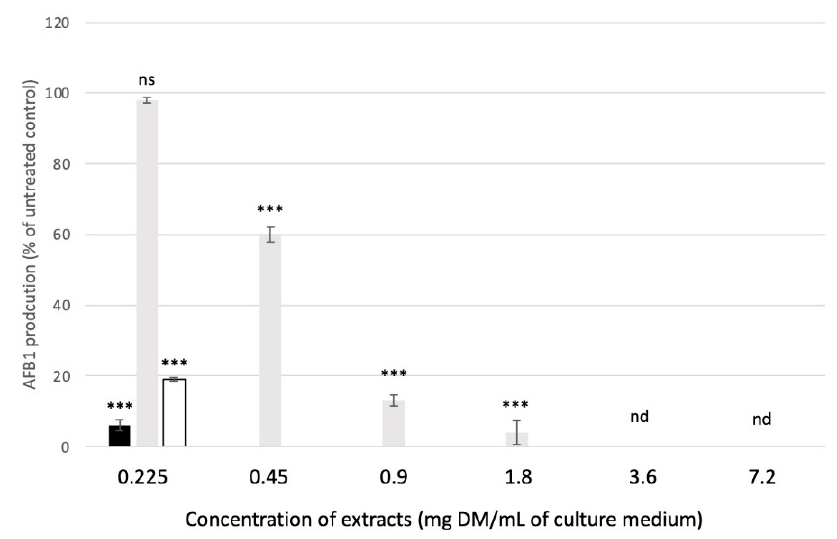
Figure 5. AFB1 production when exposed to various concentrations of mate (black bars), rosemary (grey bars) and green tea (white bars) extracts. ns: not significant. nd: not detected for the three extracts. Results correspond to the mean +/ − SD of three distinct experiments and are expressed as percentages of the AFB1 produced by untreated A. flavus control cultures. Significant differences between concentrations of the same plant extract are indicated with *** for p -value < 0.001.